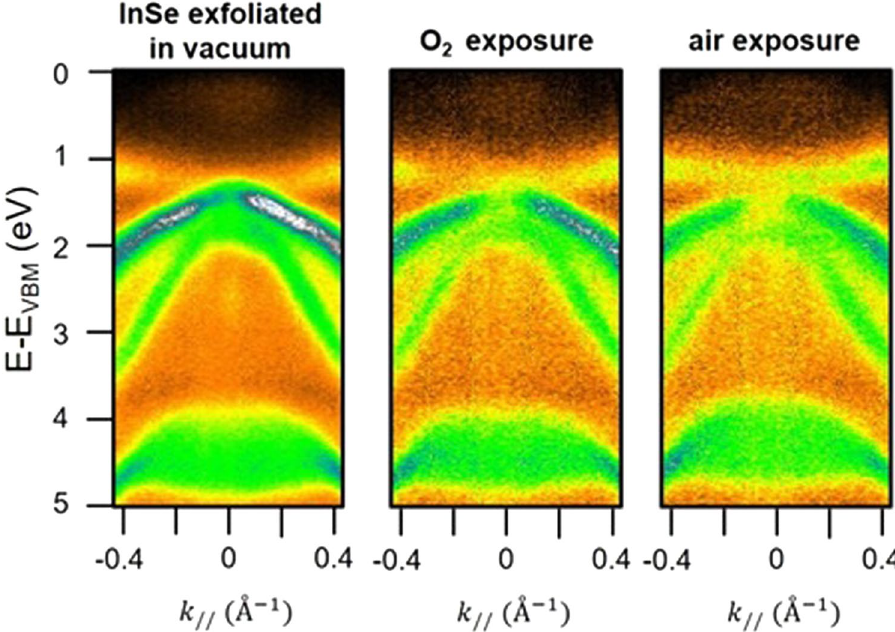
Figure 9. InSe band structure close to the Г point for the as-exfoliated sample in UHV (left panel) and its modification upon O 2 (~10 3 L, central panel) and air exposure (right panel) at room temperature. The energy scale was set to zero the VBM of the as-exfoliated